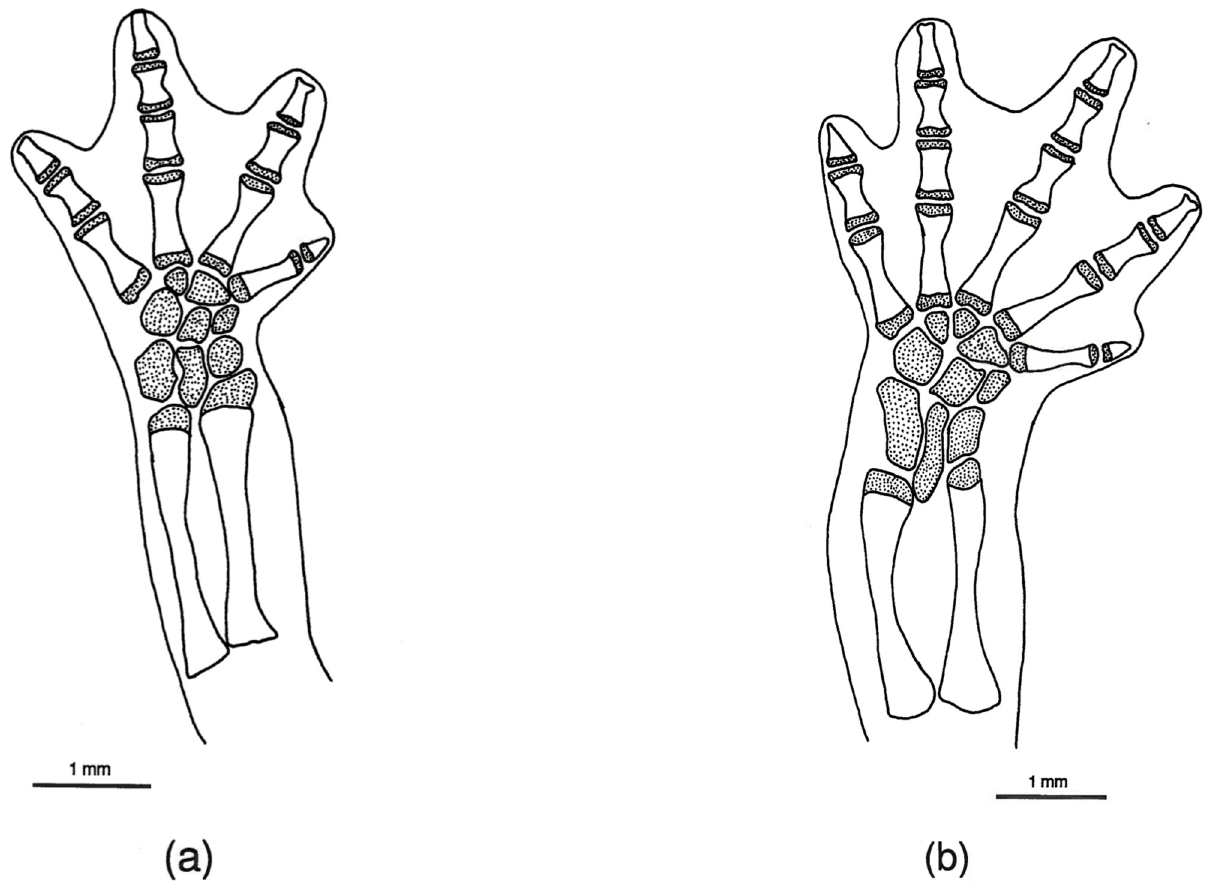
Fig 7. Chiropterotriton priscus feet. Drawings of front, left (a) and rear, left (b) feet of Chiropterotriton priscus (MVZ 192794), showing skeletal elements and the extent of interdigital webbing. Dorsal view; stippled areas represent cartilage. Elements as labeled in Fig 5. 3. Nasal-maxilla articulation: (a) separate (b) abut (c) overlap (d) fused 4. Nasal-prefrontal articulation: (a) separate (b) abut (c) overlap (d) fused 5. Nasal-frontal articulation: (a) separate (b) overlap Posterior Skull 6. Frontal-frontal articulation: (a) separate (b) abut (c) overlap (d) interdigitate 7. Parietal-parietal articulation: (a) separate (b) abut (c) overlap (d) interdigitate 8. Frontoparietal fontanelle: (a) extensive (b) reduced (c) absent (Fig 10) 9. Parietal process development: (a) absent (b) present 10. Otic process development: (a) absent (b) one process present (c) two processes present 11. Squamosal process: (a) absent (b) present Ventral Skull 12. Vomer preorbital process development: (a) absent (b) present but reduced (c) present